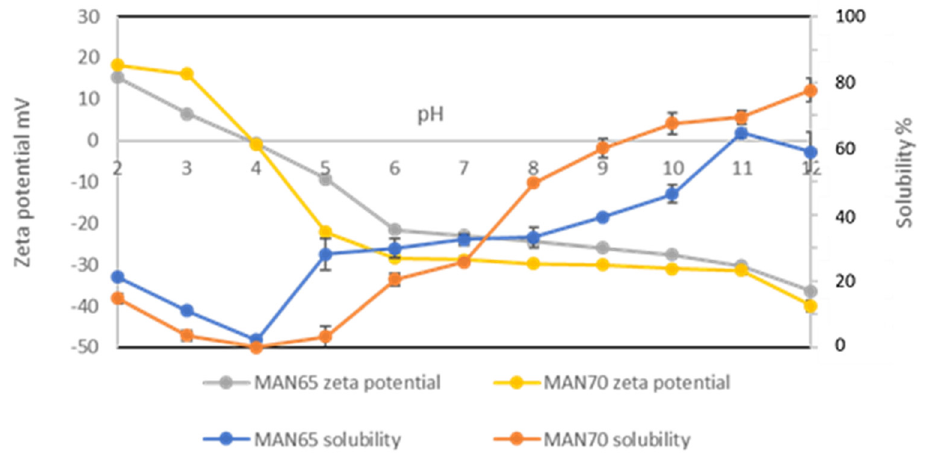
Figure 2. The zeta potential and solubility of thraustochytrid (MAN65 and MAN70) protein isolates as a function of pH.